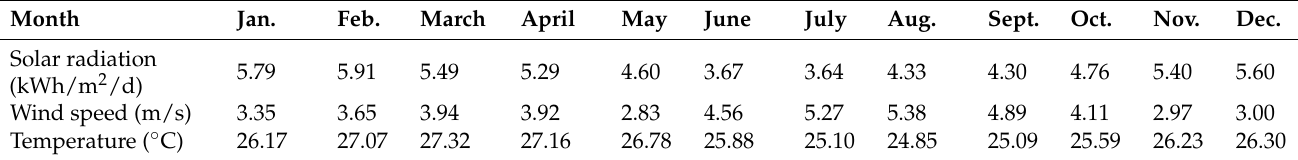
Table 7. Solar radiation, wind speed, and temperature of the area.